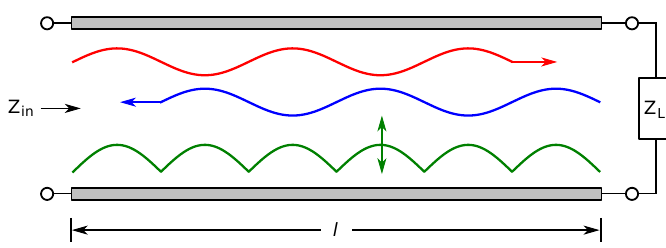
Figure 2. Incident signal ( red ), traveling towards the load, and the reflected signal ( blue ), due to impedance mismatch. The combination of the two waves results in a standing wave ( green ).